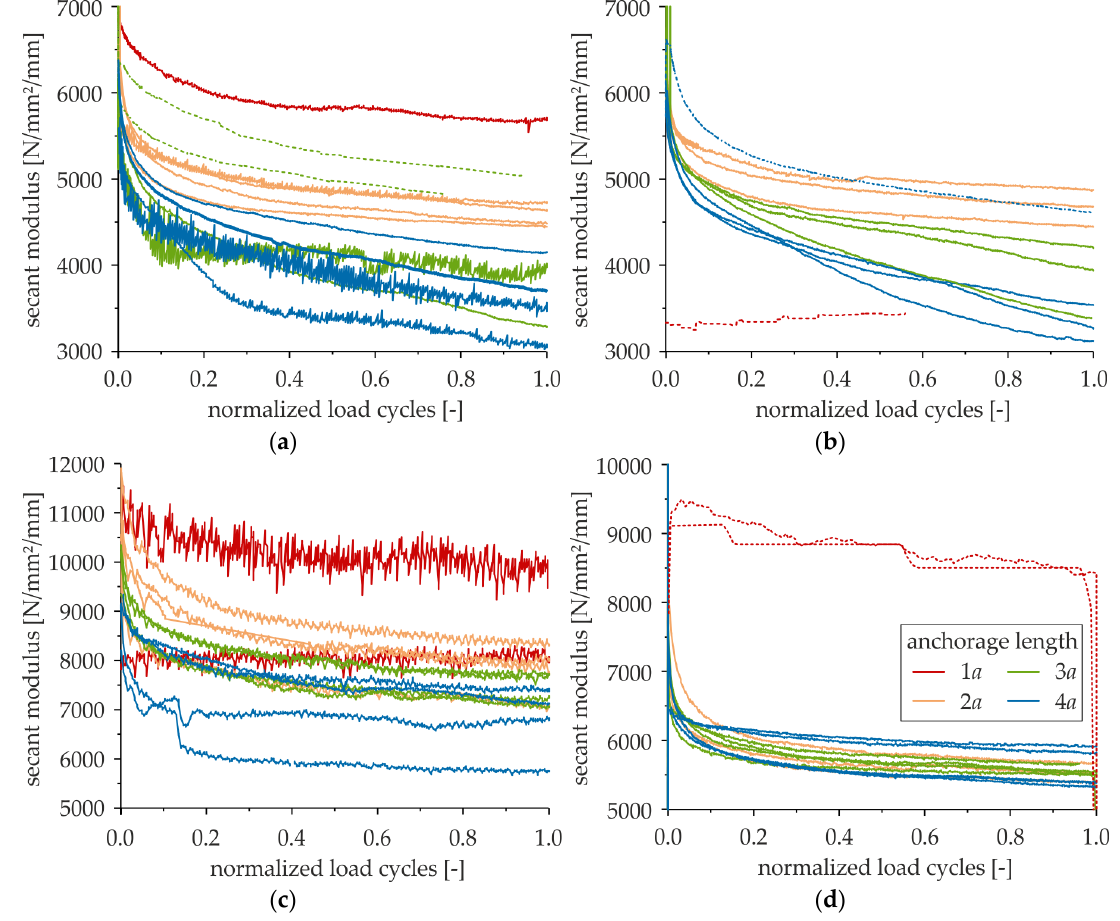
Figure A7. Comparison of the normalized development of the secant modulus depending on the anchorage length: ( a ) σ min / σ max = 30%/90%; ( b ) σ min / σ max = 30%/95%; ( c ) σ min / σ max = 50%/70%; and ( d ) σ min / σ max = 50%/90%.